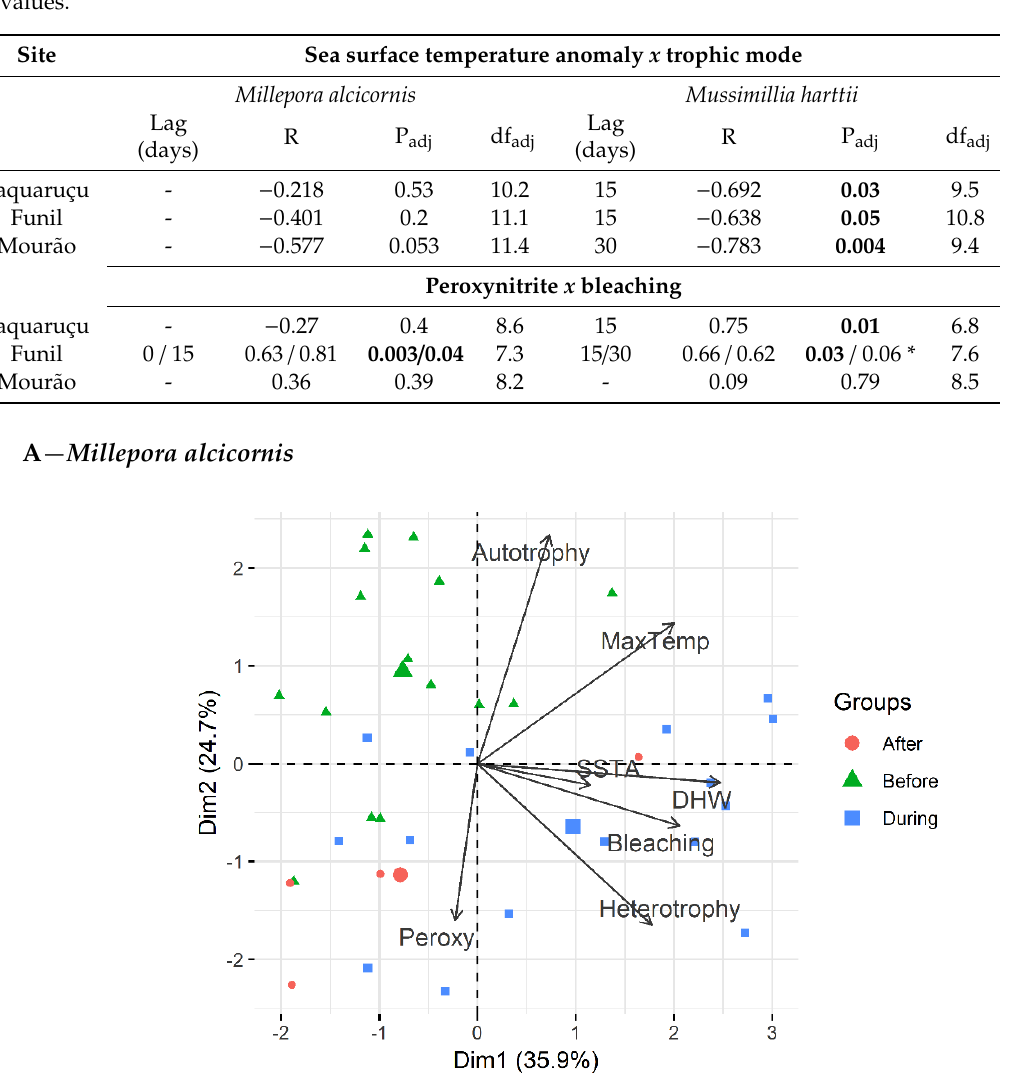
Table 2. Cross-correlation analysis testing i) the relationship between sea surface temperature